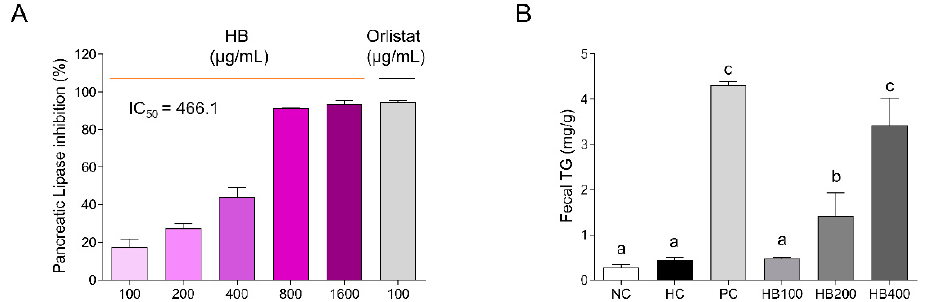
Figure 1. Effects of HB on pancreatic lipase inhibition and TG contents in the feces for HFD-fed mice. ( A ) Pancreatic lipase inhibition of HB; ( B ) fecal TG contents, NC–normal diet control; HC–high-fat diet (HFD) control; PC–HFD with orlistat at 20 mg/kg; HB100–HFD with HB 100 mg/kg;